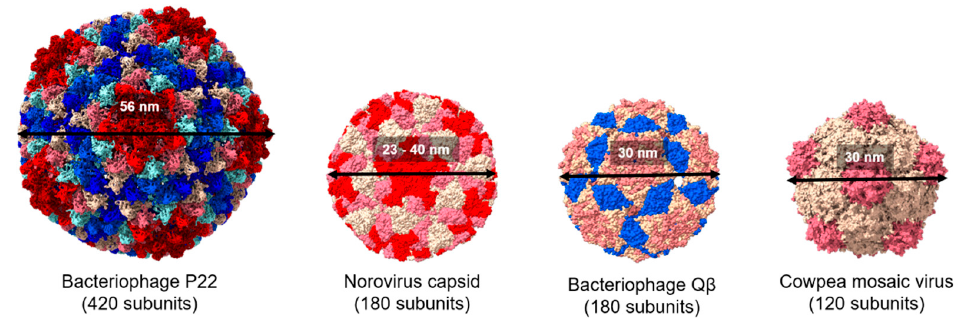
Figure 2. Comparison of the structure of viral protein cages. Space filling models showing the structure of bacteriophage P22, norovirus capsid, cowpea mosaic virus, and bacteriophage Q β (Protein Data Bank IDs: 2XYZ, 1IHM, 1NY7, and 1QBE, respectively). Subunit chains are distinguished by different colors. All the structures were generated using UCSF ChimeraX.